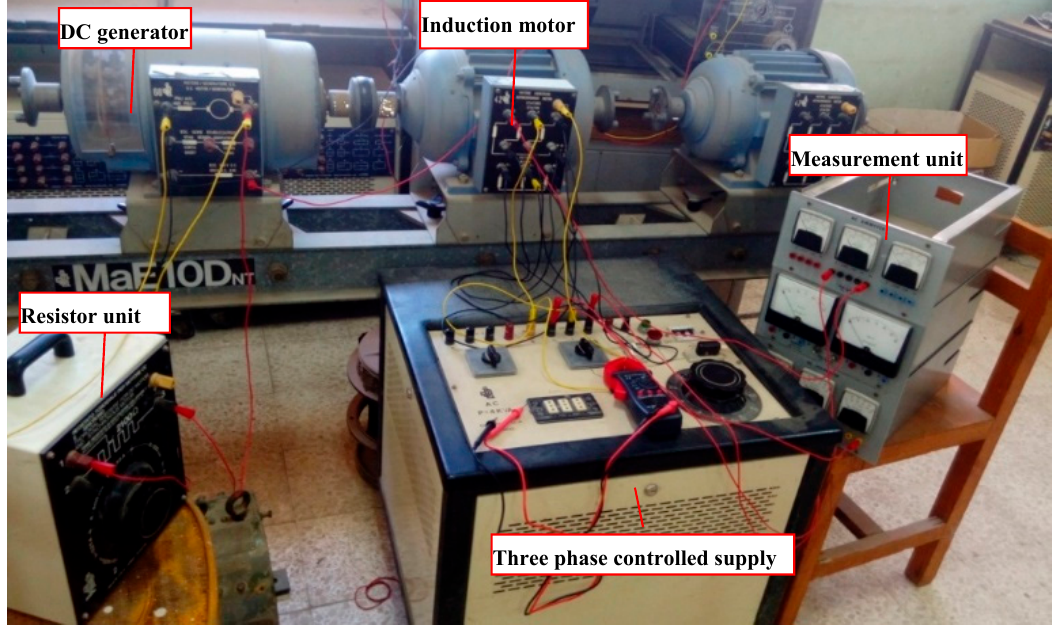
Figure 4. Photograph of the experimental setup.